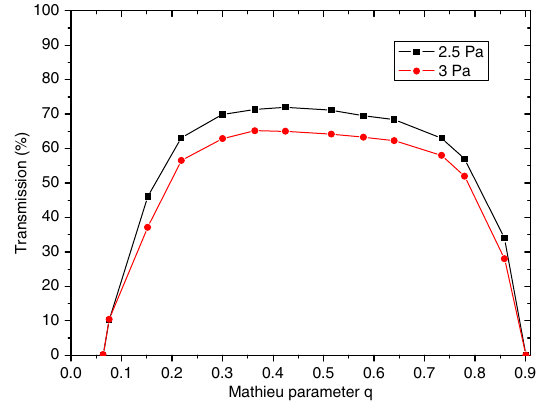
FIG. 8. Stability diagram at 1 μ A beam current: variation of the transmission as a function of the Mathieu parameter q for various buffer gas pressure.